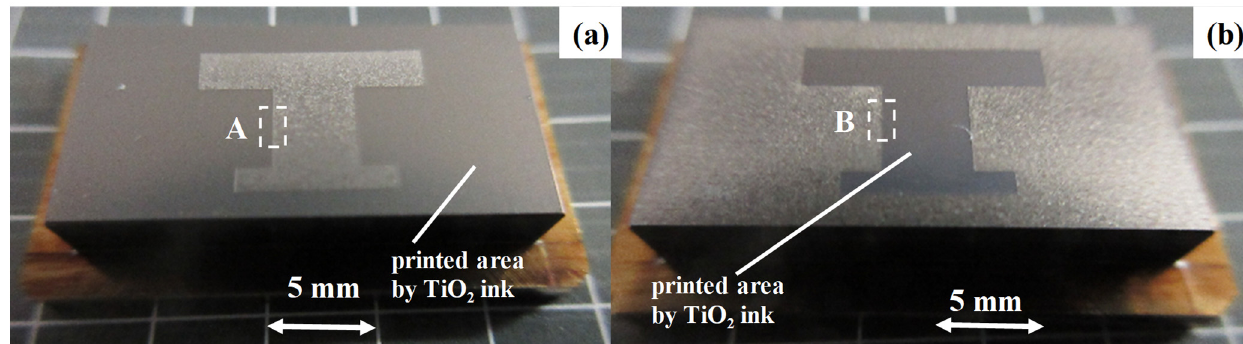
Figure 5. Optical microscopy images on nitrided substrates with negative and positive micropat- terns. ( a ) Substrate with the negative micropattern, and ( b ) substrate with the positive